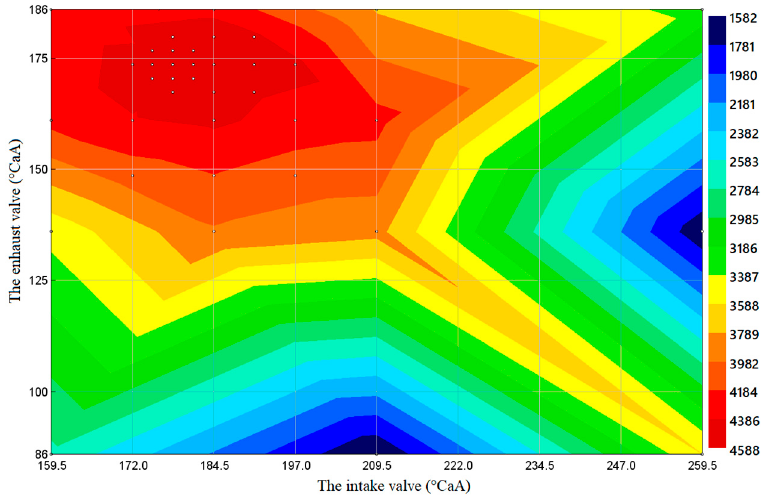
Figure 9. 100% load condition.